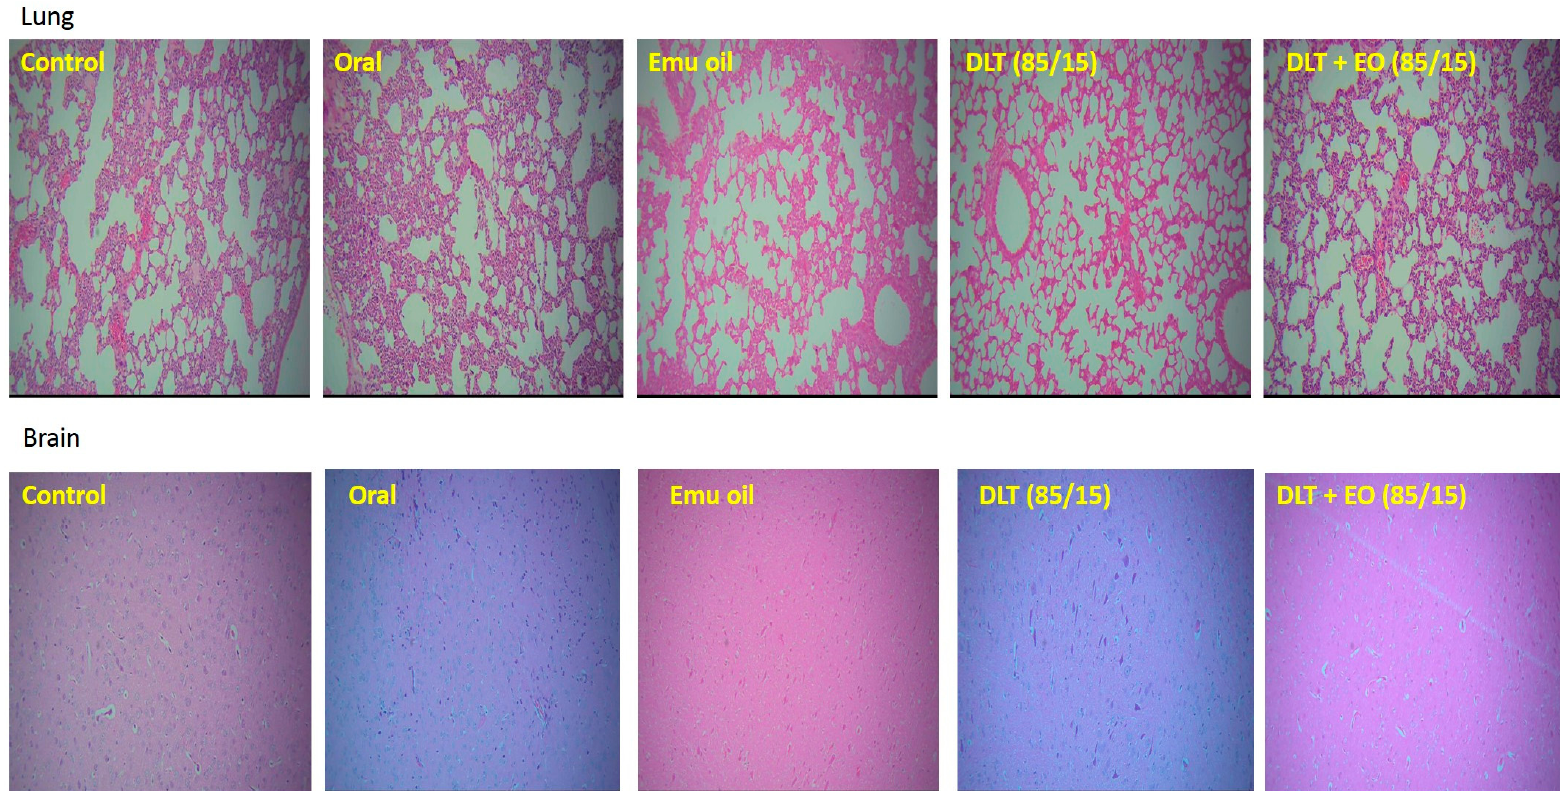
Figure 4. Photomicrographs from the lung and brain of the control (untreated), orally treated (TAMX), topically treated with emu oil (without the presence of drugs), formulations; DLT–EO (85:15) at day 18 post treatment. The lung showing normal alveoli with mild scattered non-specific inflammatory cells (H&E, 100×), in normal brain (H&E, 100×). No evidence of tumor metastasis in both the lung and brain of all groups (treated and untreated) were observed. Note: DLT—deformable liposomes, DLT–EO—deformable liposomes with emu oil.